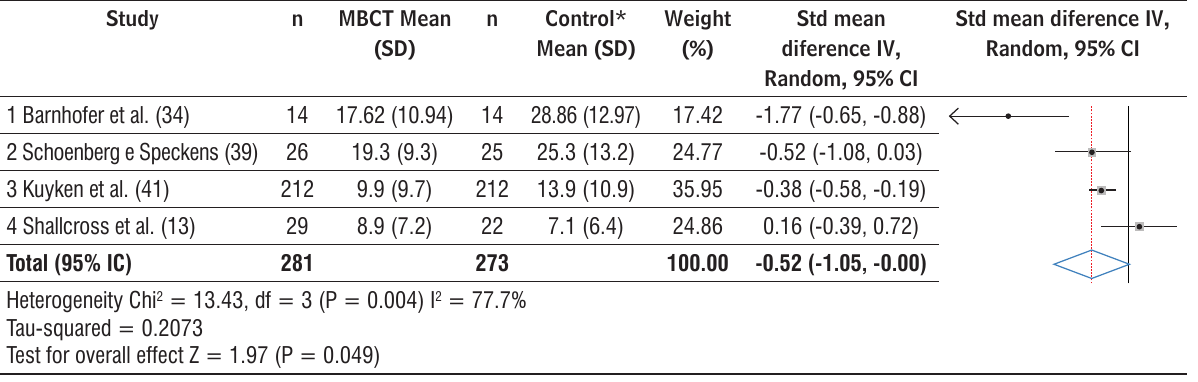
Figure 2 - Meta-analysis of studies evaluating effects of MBCT on depression.